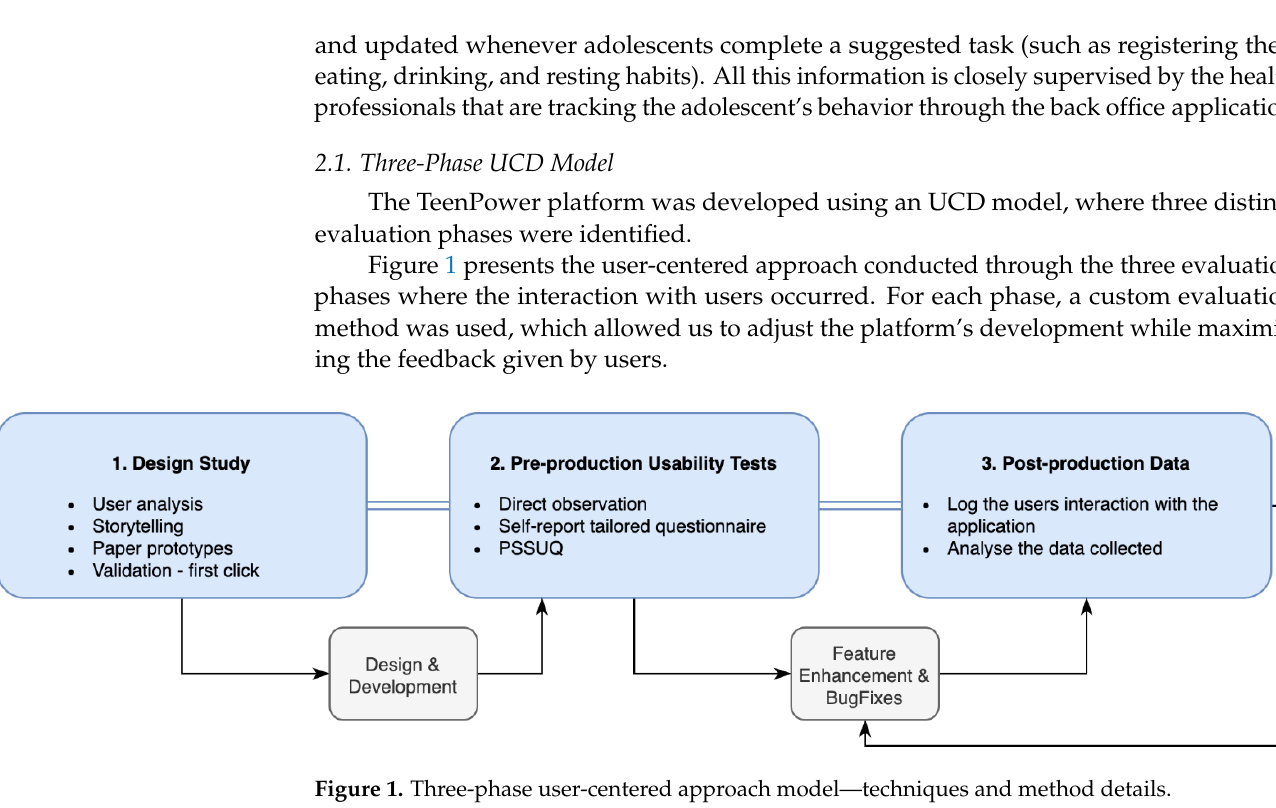
Figure 1. Three-phase user-centered approach model — techniques and method details.